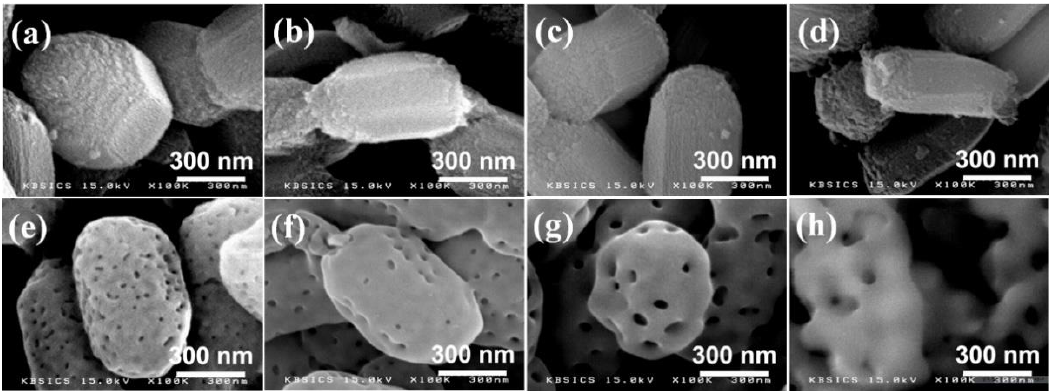
Figure 2. SAXS ( A ) and XRD ( B ) patterns of (a) SBA15-Na-40-500, (b) SBA15-Na-40-600 and (c) SBA15-Na-40-650 after thermal treatment with different temperatures (500 – 650 °C) using Si/Na = 40. Inset in Figure 2A shows the magnified SAXS patterns in the range of q = 0.10 – 0.20 for samples.